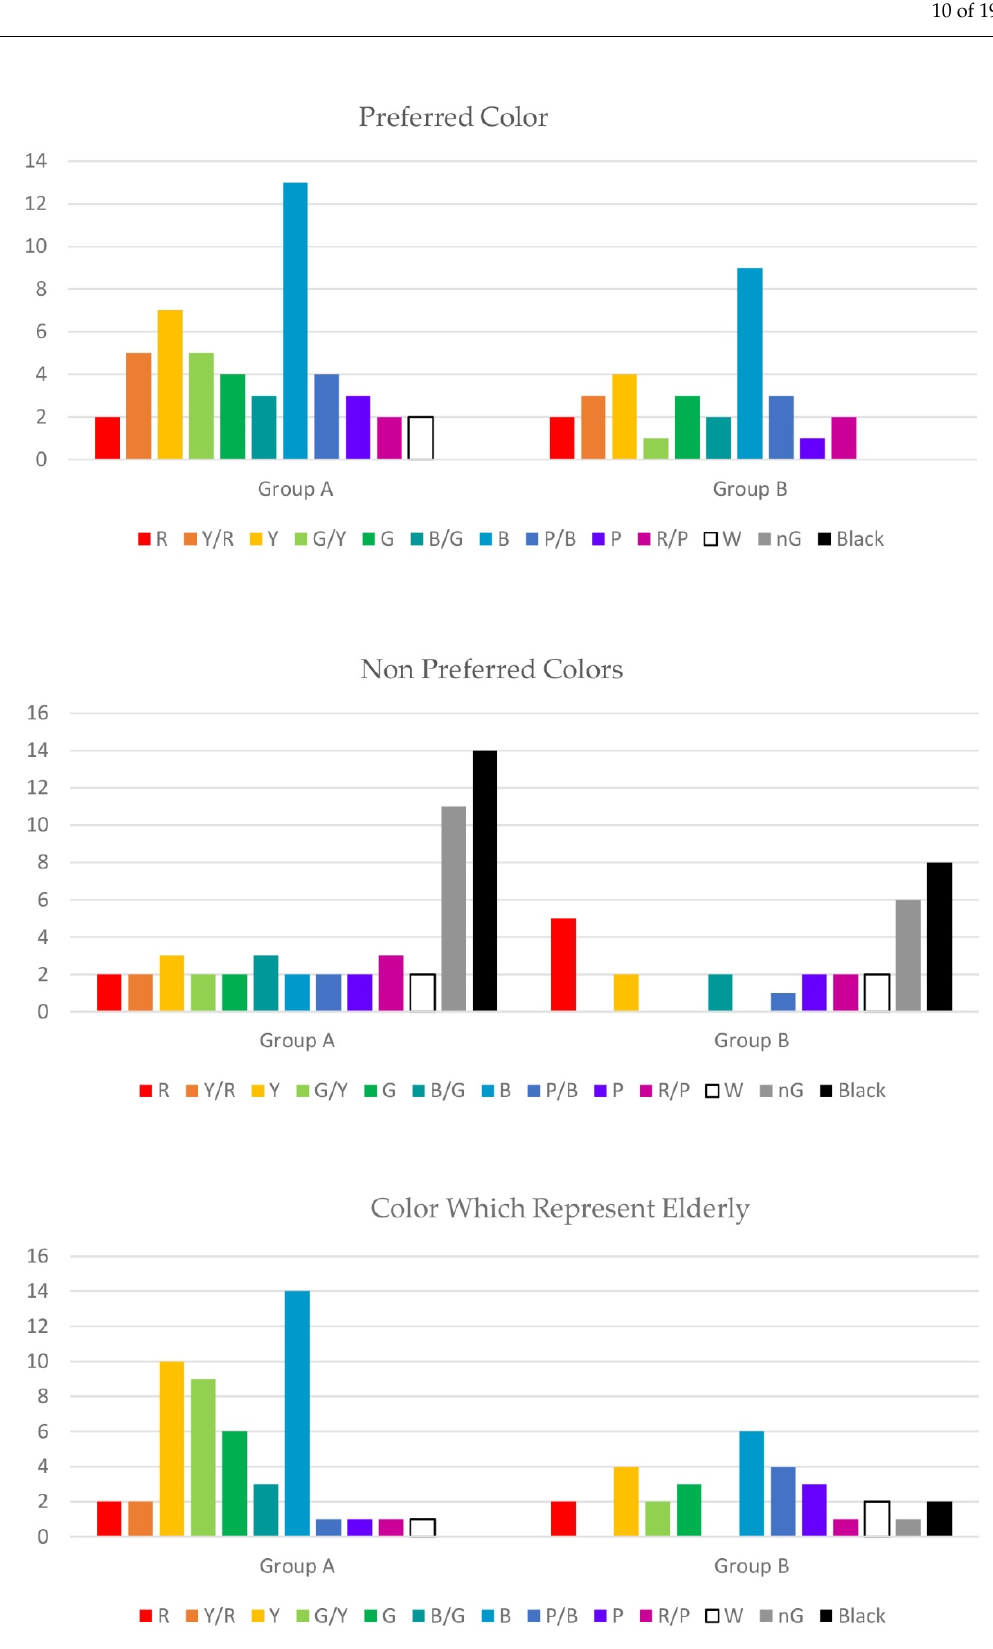
Figure 6. Statistical analysis showing the number of ‘Preferred’, ‘Non-Preferred’, and the ‘Color Which Represents Them’ participants, as provided in Table 2.